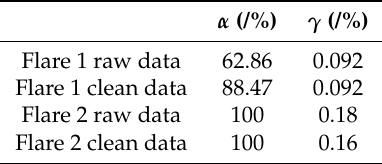
Table 5. Partial least squares-discriminant analysis (PLS-DA) results on raw and clean data